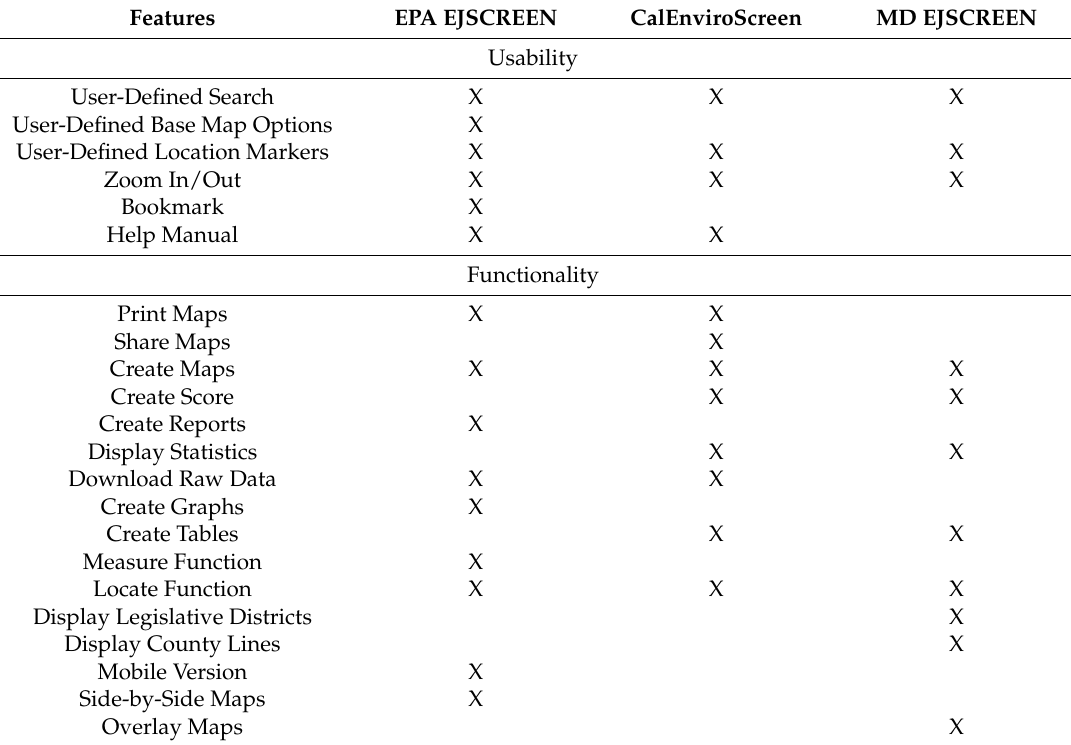
Table 3. Comparison of usability and functionality across the screening